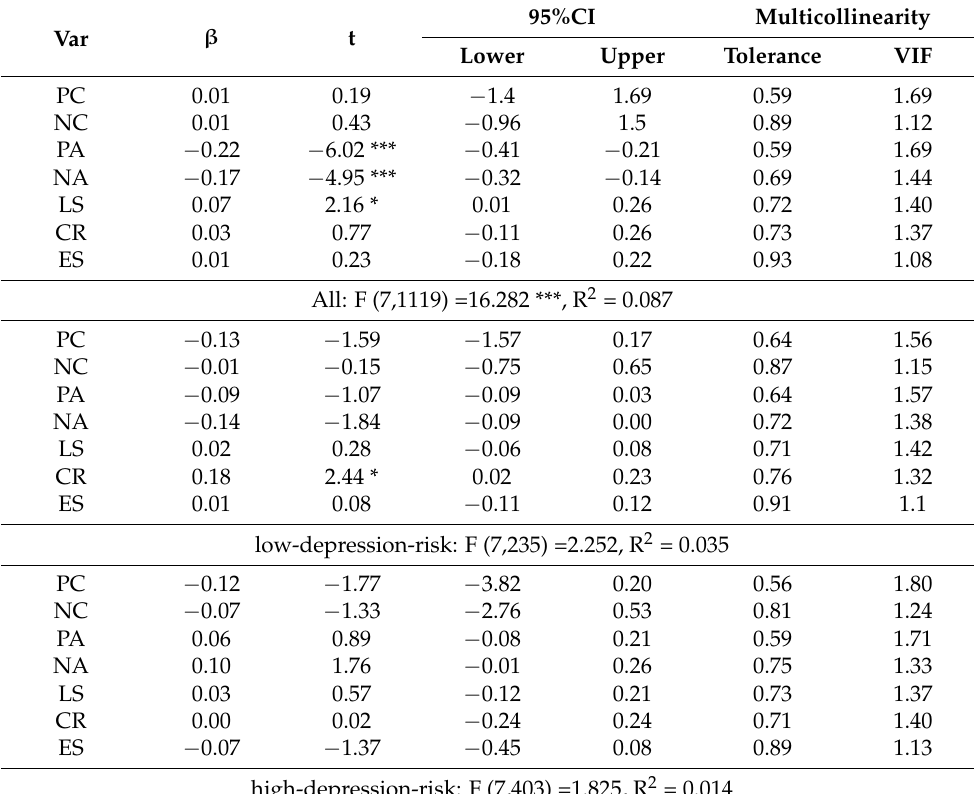
Table 3. Regression Analysis of Variables Relationship.